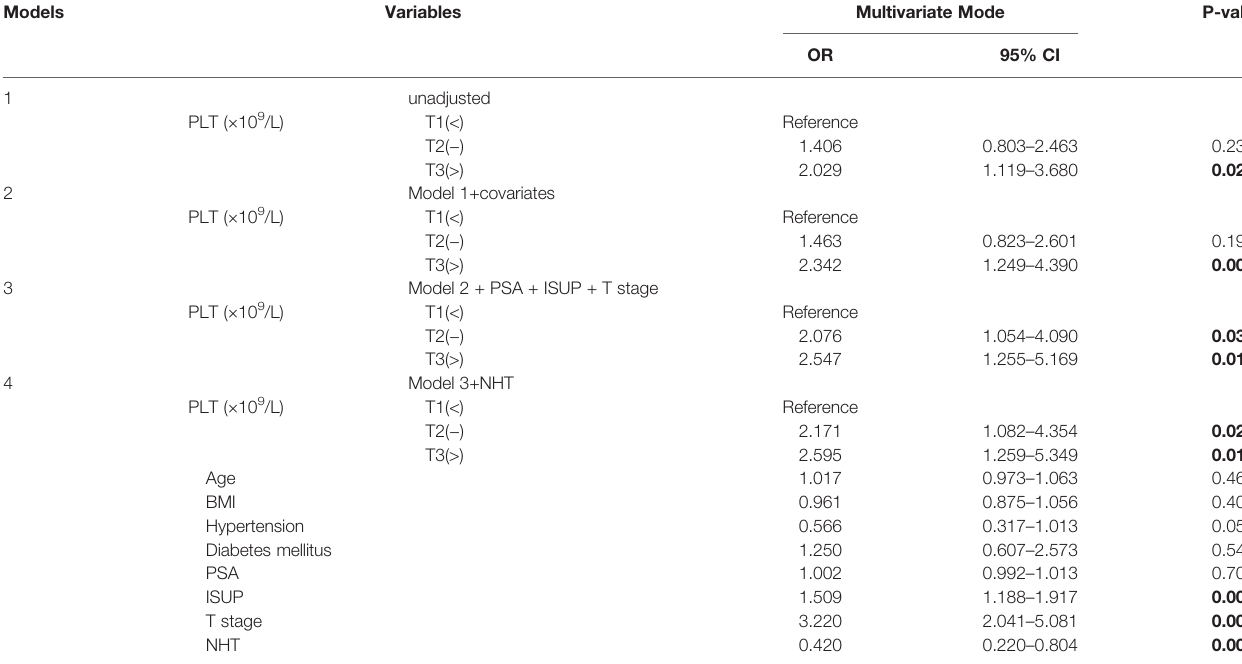
Multivariate regression stepwise models are shown. The bold value indicated statistical signi fi cance. The dependent variable was PNI of PCa. Model 1 was unadjusted. Model 2 was corrected for covariates including age, BMI, hypertension, and diabetes mellitus. Model 3 was additionally corrected for PSA, ISUP, stage T based on Model 2; Model 4 was additionally corrected for NHT based on Model 3. PLT, platelet; PNI, perineural invasion; PCa, prostate cancer; PSA, prostate-speci fi c antigen; ISUP, International Society of Urological Pathology; NHT, neoadjuvant hormonal therapy; BMI, body mass index; PSA, prostate-speci fi c